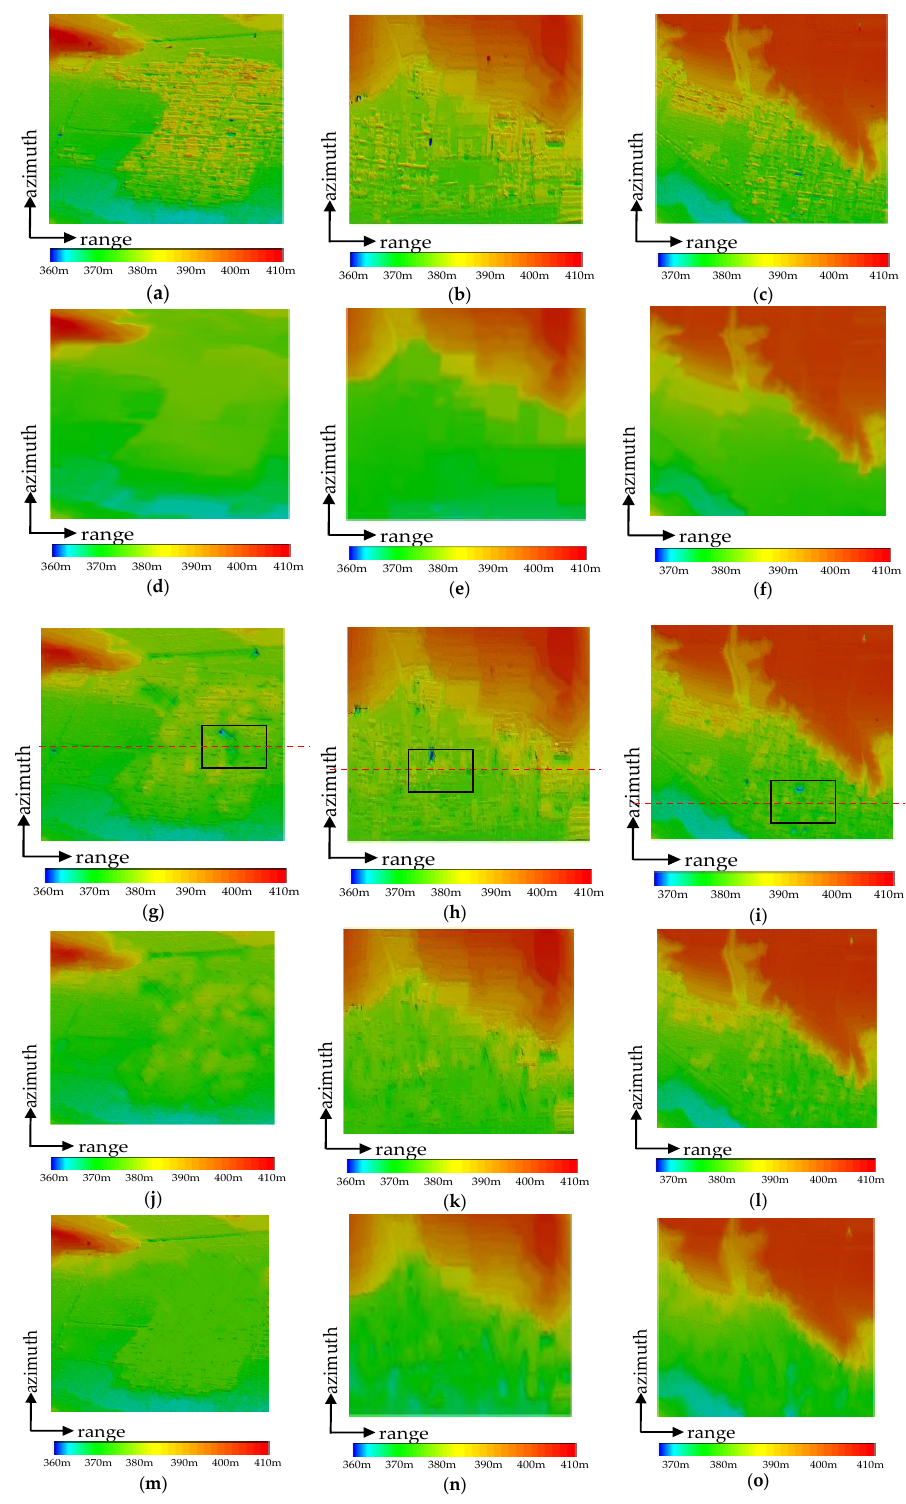
Figure 10. Visual comparison of before and after processing of the InSAR DSM, where ( a – c ) are the original DSMs, ( d – f ) are the reference DEMs obtained by laser detection and ranging (LiDAR), ( g – i ) are the reconstructed DEMs based on surface fitting, ( j – l ) are the reconstructed DEMs based on coherent Markov random field (CMRF)+surface fitting, and ( m – o ) are the reconstructed DEMs based on proposed method.